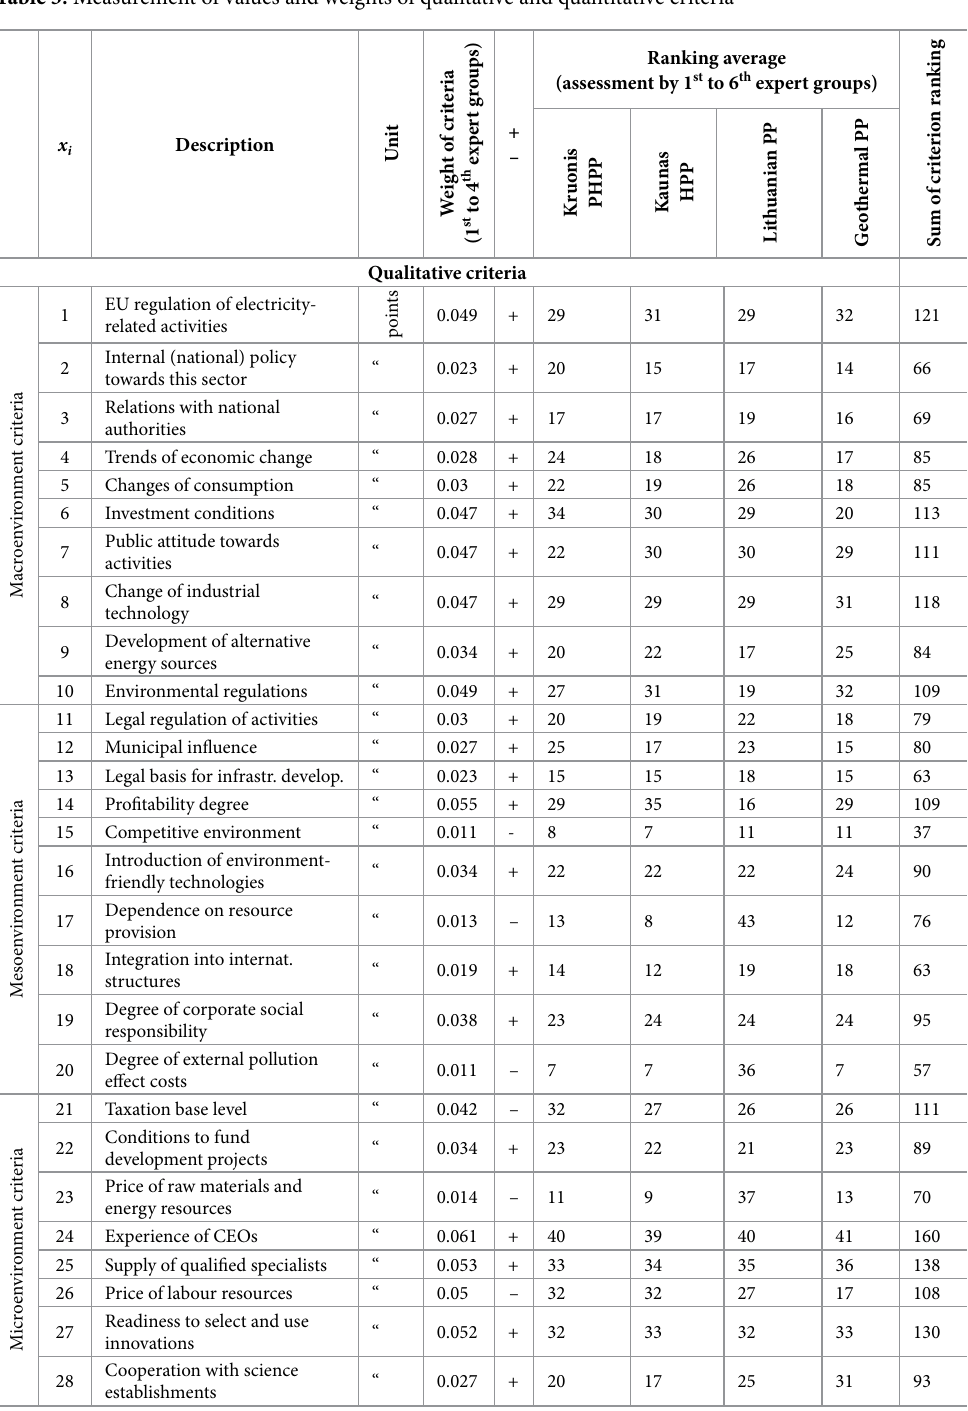
ranking average (assessment by 1 st to 6 th expert + –